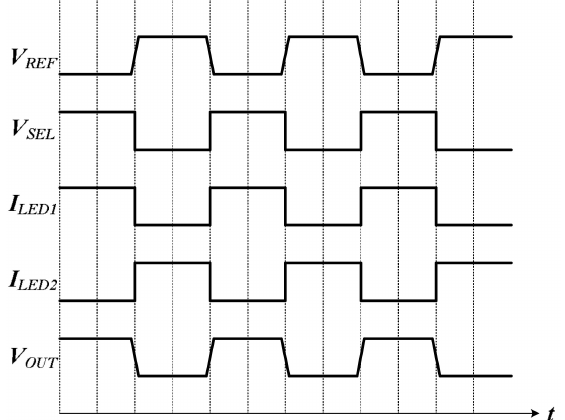
Figure 10. Operating waveform of proposed adaptive driving voltage and energy-saving control